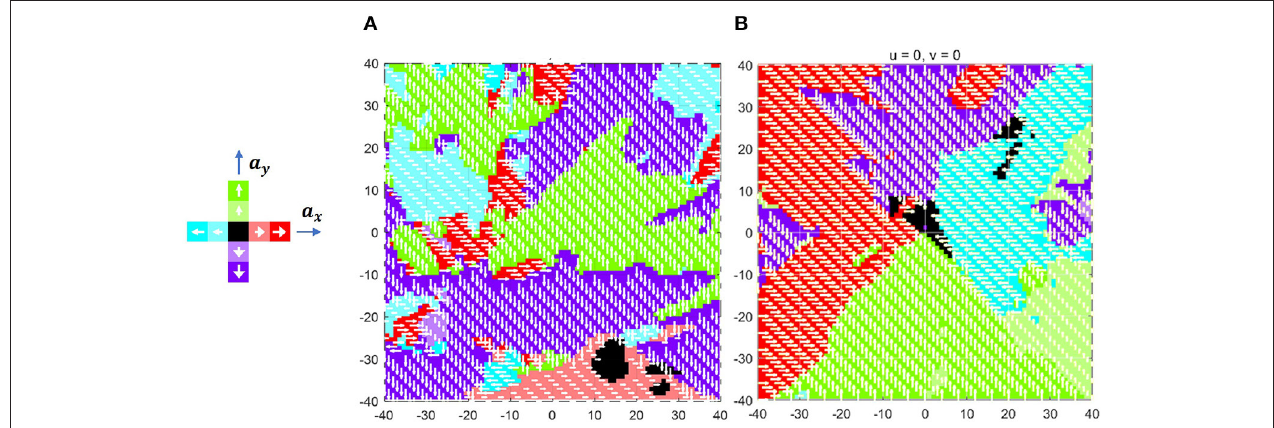
FIGURE 8 | Action field (A) before and (B) after